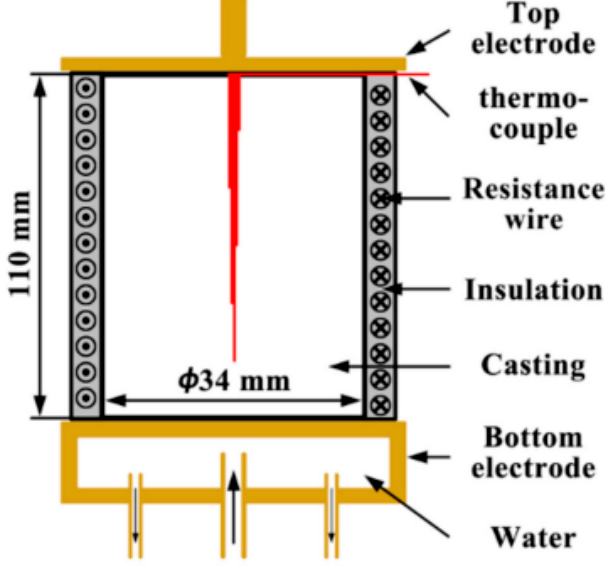
Figure 3. Scheme of the experimental apparatus [4].